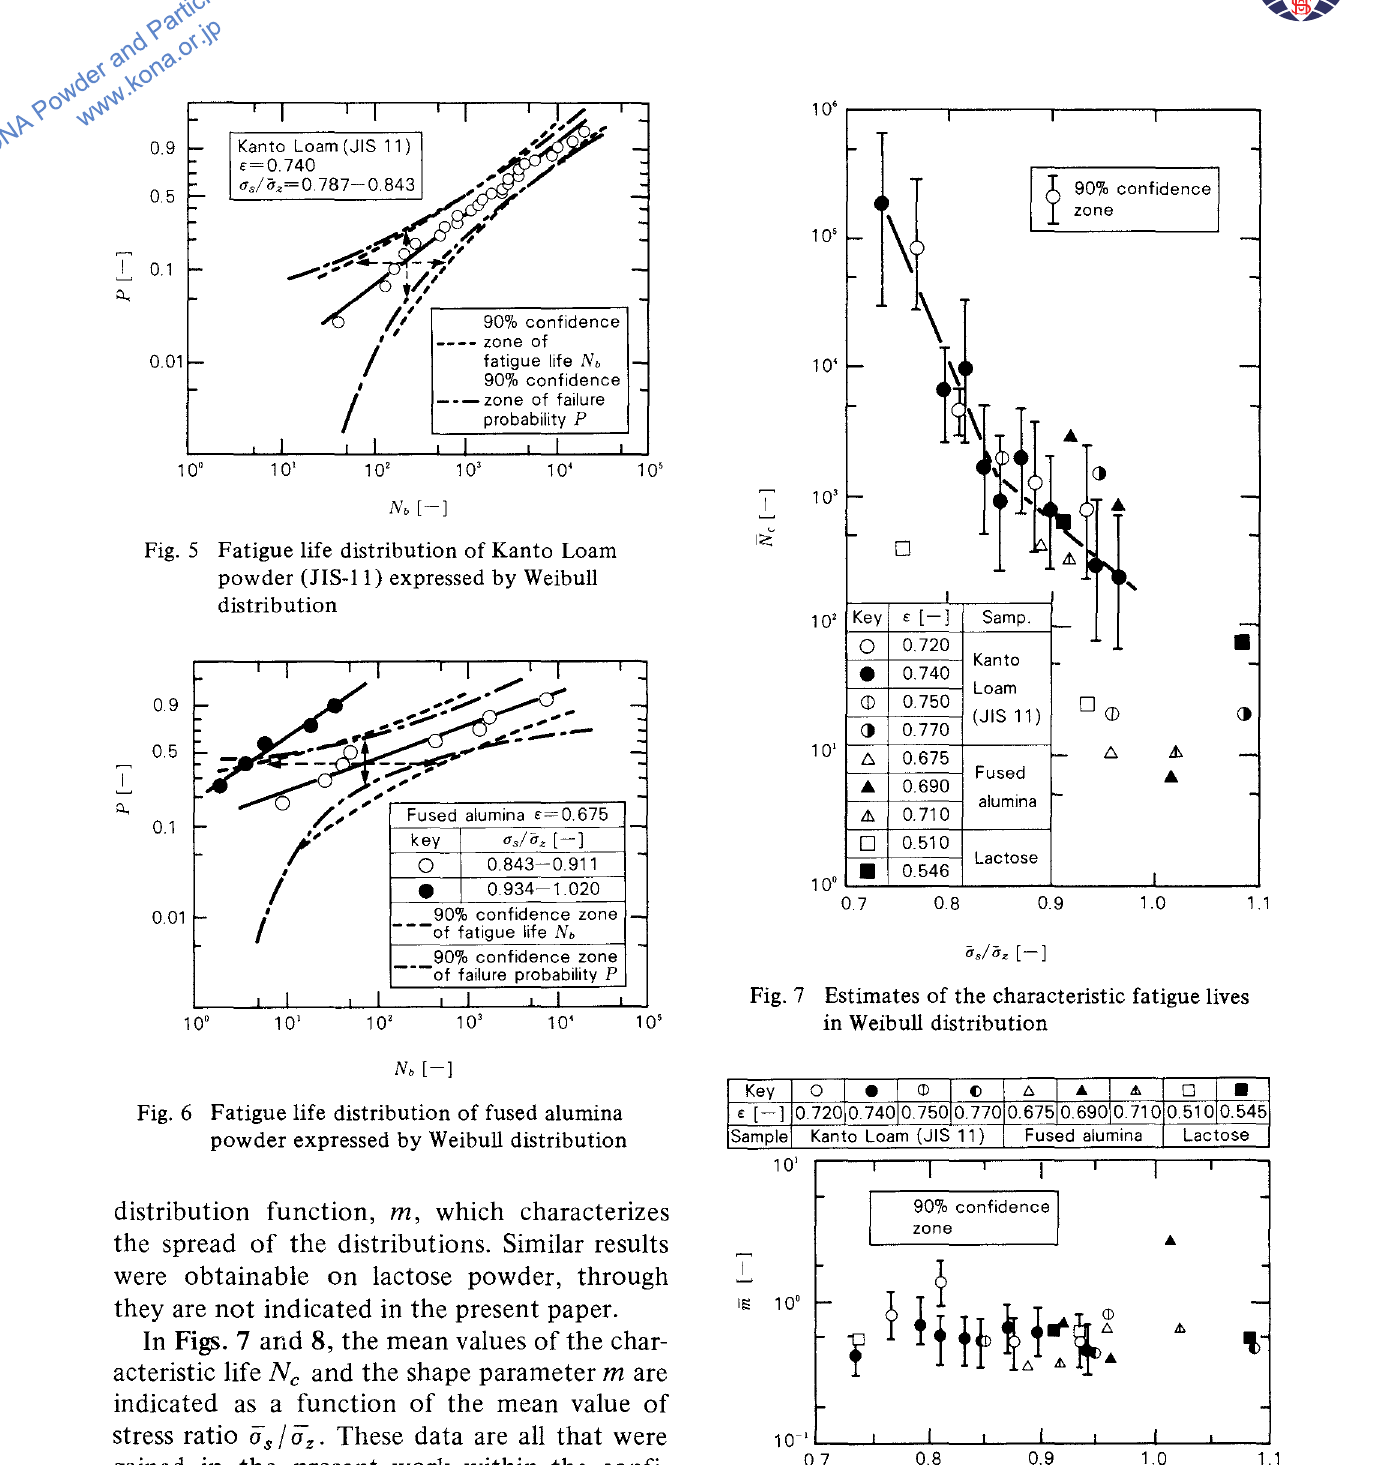
Fig. 8 Estimates of the shape parameters in Weibull